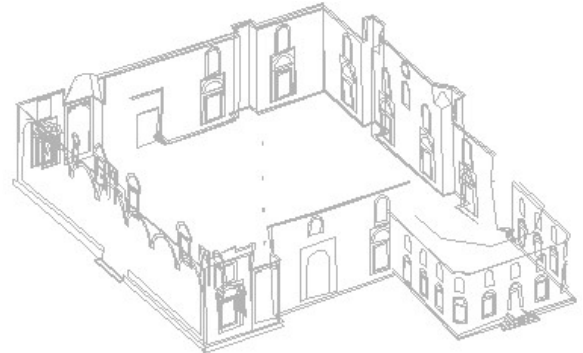
Figure 4. Photogrammetric wireframe model